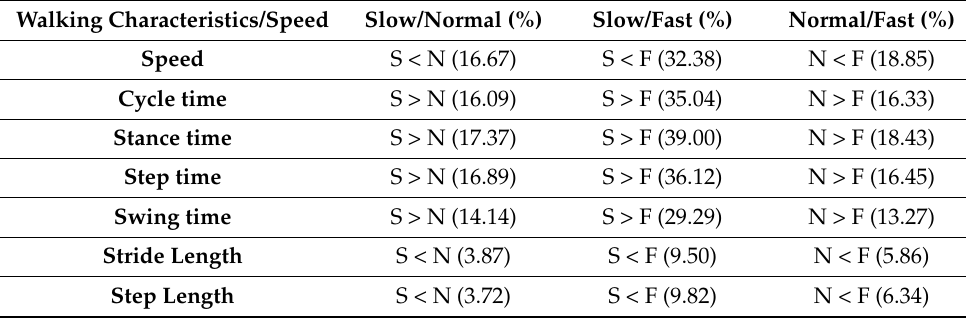
Table 1. The different percentages of significant walking characteristics. Walking